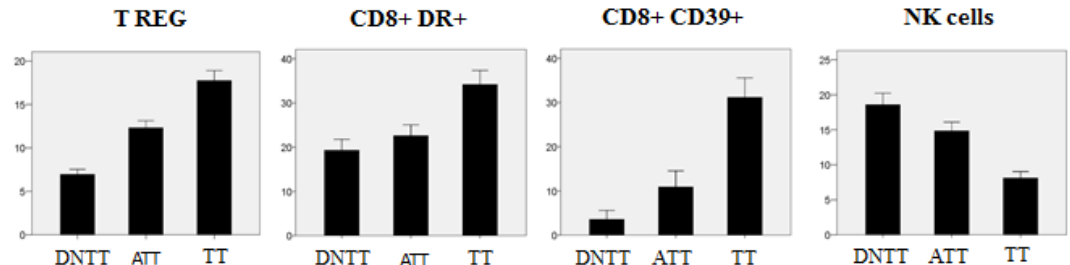
Figure 3. Variations in the percentage of lymphocyte subpopulations and natural killer (NK) cells in different areas of tumor and “normal” adjacent tissues measured by flow cytometry. DNTT—distant non tumor tissue, ATT—adjacent tumor tissue, TT—tumor tissue. The treg cell subset was defined as CD127low CD25bright CD4+. The number of Treg was calculated as a percentage of total number of CD4+ cells, while the CD8+ DR+ and CD8+CD39+ cell levels are shown as a percentage of CD8+ cells. NK cells were determined by the selection of CD45+ CD3 − CD20 − cells in the FSC low /SSC low gate [31]. Tregs and CD8+CD39+ lymphocytes show increased presence closer to the tumor nest, while the percentage of NK cells is lower in TT as compared to other areas.